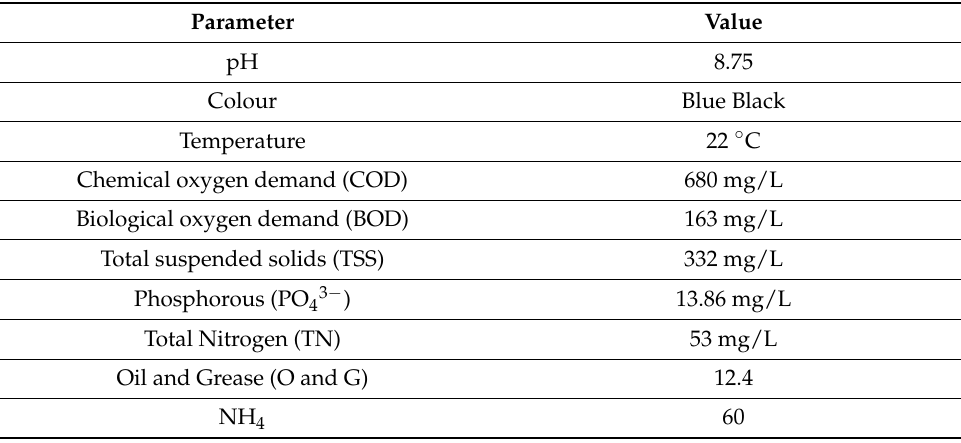
Table 5. Basic physico-chemical characteristics of raw domestic